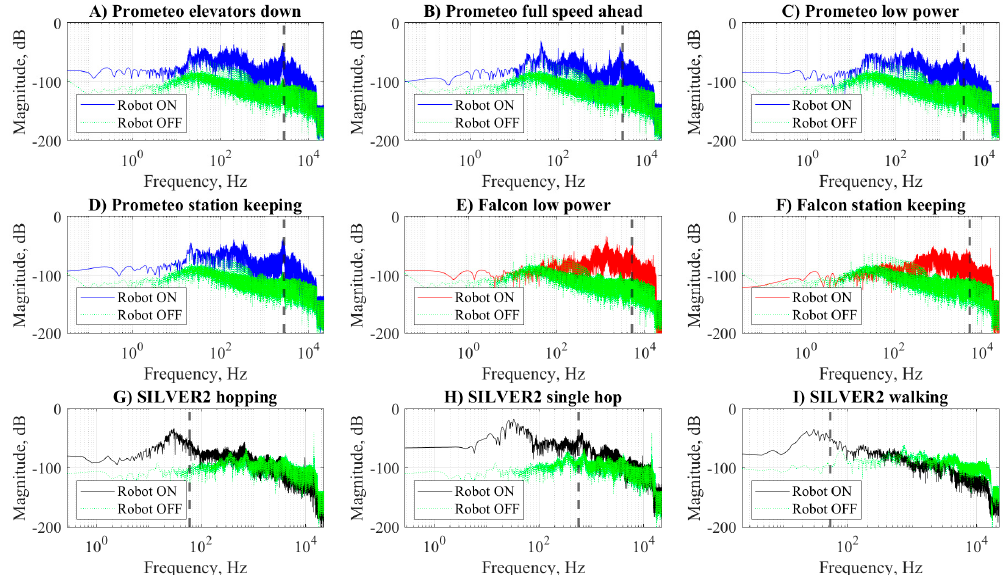
Figure 4. Power spectral density of Prometeo (blue), Falcon (red), and SILVER2 (black) performing various maneuvers. For each maneuver, the power spectral density of the ambient noise recorded when the robots were o ff is reported (green). The vertical dotted line indicates the spectral roll o ff point of each f RO of each signal. The reference value for the magnitude in dB was 1/√2 . The power spectral densities of the ANs of the four recording sessions are reported in Figure 4.